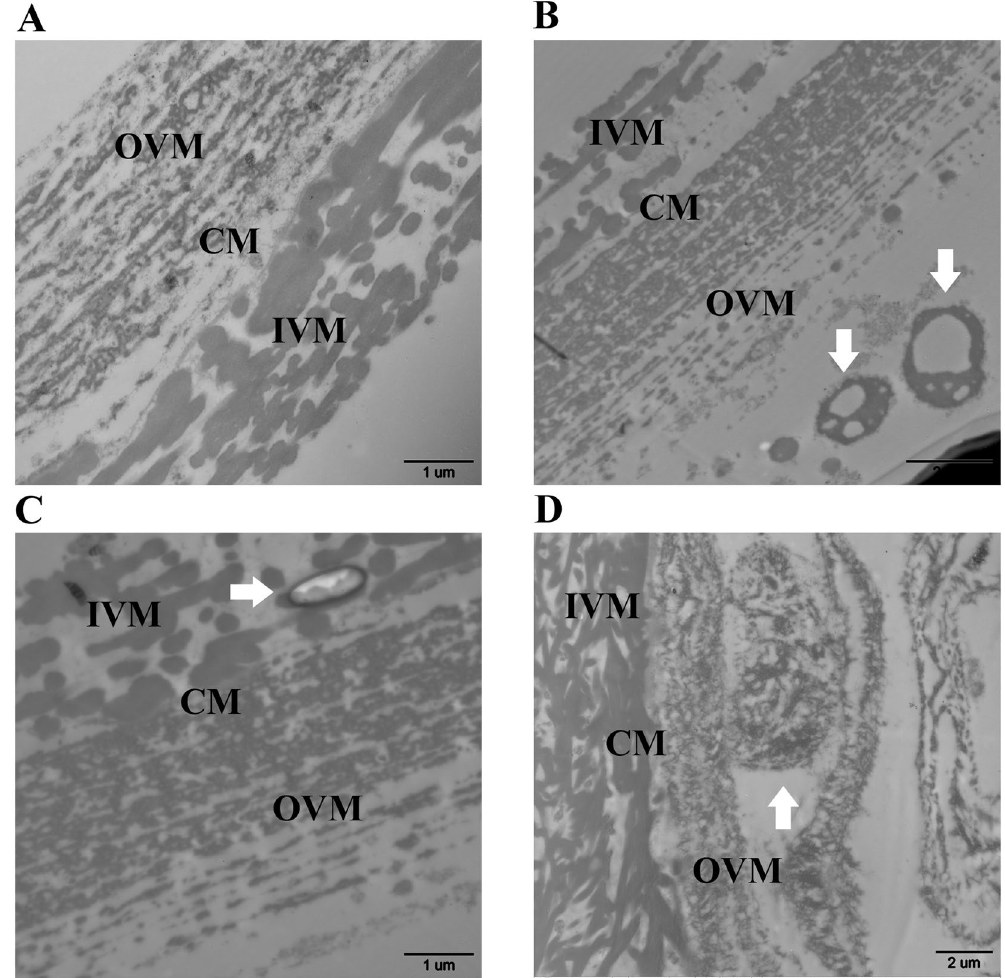
Figure 1. Transmission electron microscopy (TEM) images of the maternal cells on the VM. ( A ) The typical three layers of the VM ( × 20k). ( B ) Granulosa cells (arrowhead) on the OVM ( × 12k). ( C ) Elongated nuclei (arrowhead) stuck between the CM and IVM ( × 20k). ( D ) Apoptotic granulosa cells (arrowhead) on the OVM ( × 8k). OVM: outer VM; CM: continuous membrane; IVM: inner